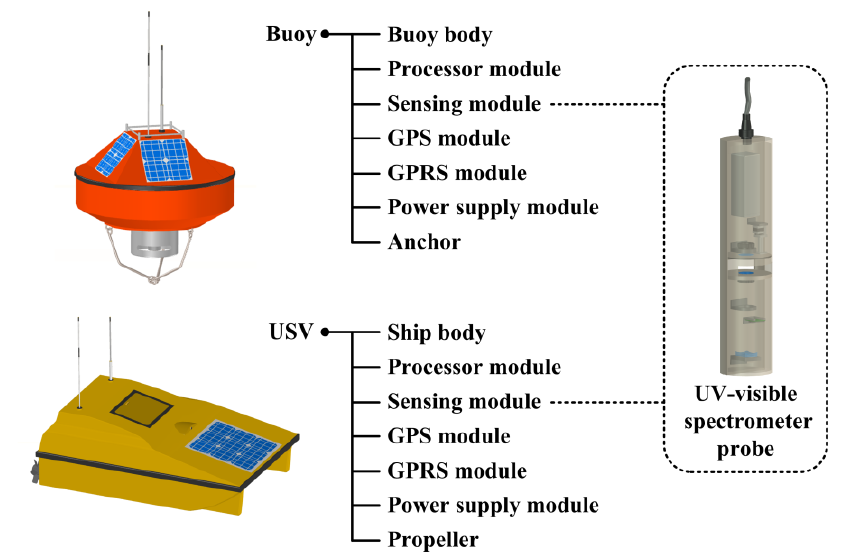
Figure 3. Configuration of stationary and mobile wireless sensor nodes.